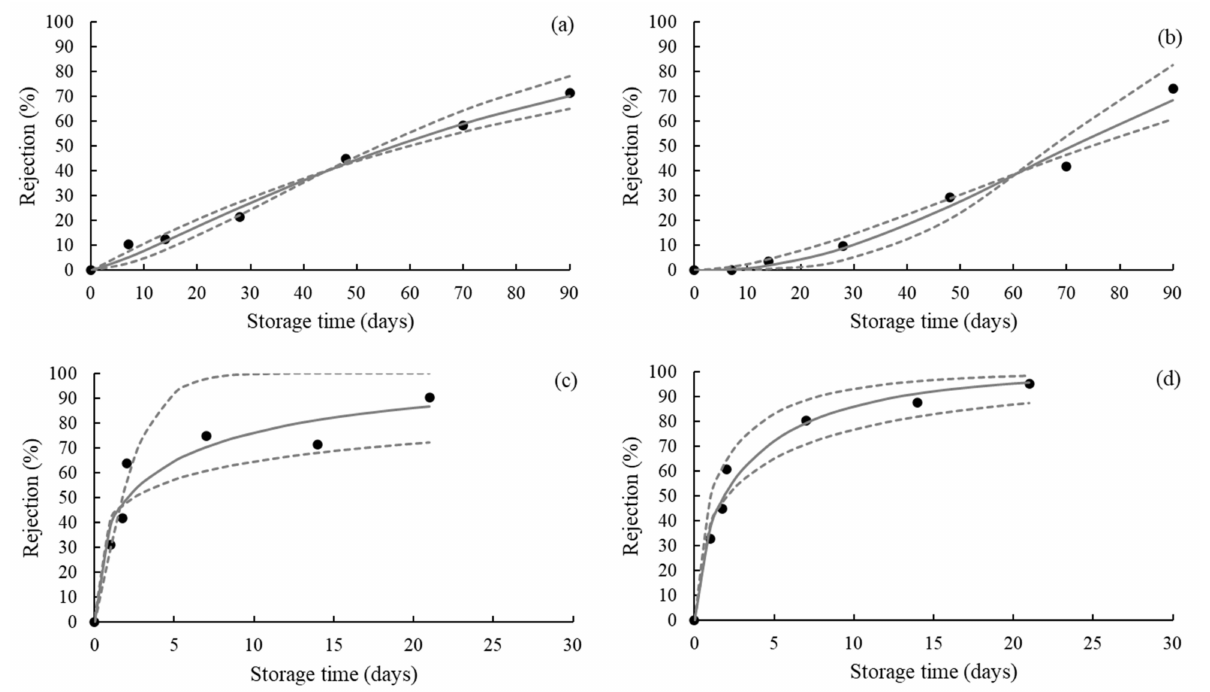
Figure 6. Consumer rejection probability of strawberry leather during storage at 22.5% RH with no illumination ( a ), 22.5% RH with illumination ( b ), 52.3% RH with no illumination ( c ), and 52.3% RH with illumination ( d ). The filled symbols represent experimental data. The full lines represent the parametric rejection function based on the Weibull distribution. The dashed lines are confidence intervals for 95%.